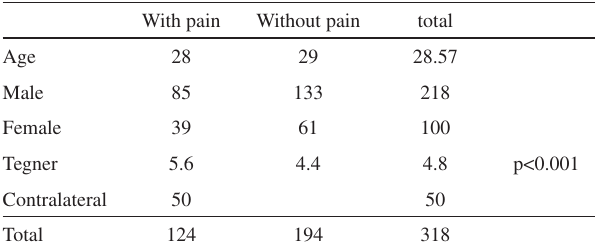
Table 1 - Comparison of individuals with and without pain